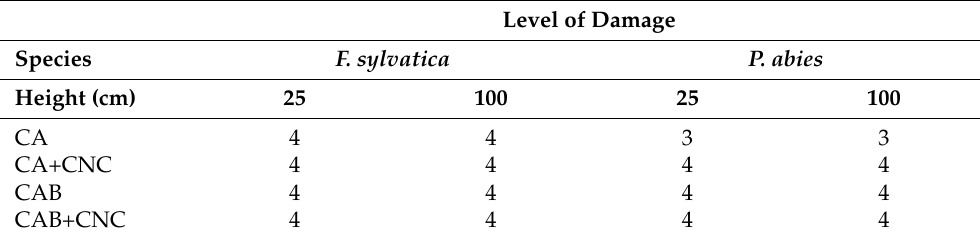
Table 5. Level of damage (ISO, 4211-4:1988) for the impact test on the acrylic coatings. The sphere was dropped at two different heights (25 and 100 cm).